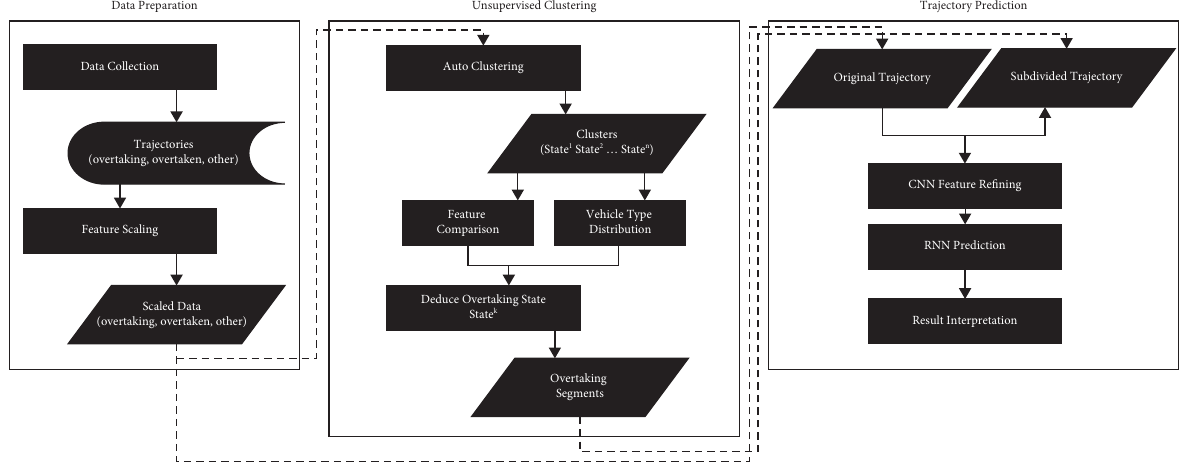
Figure 1: Flow chart of data process and